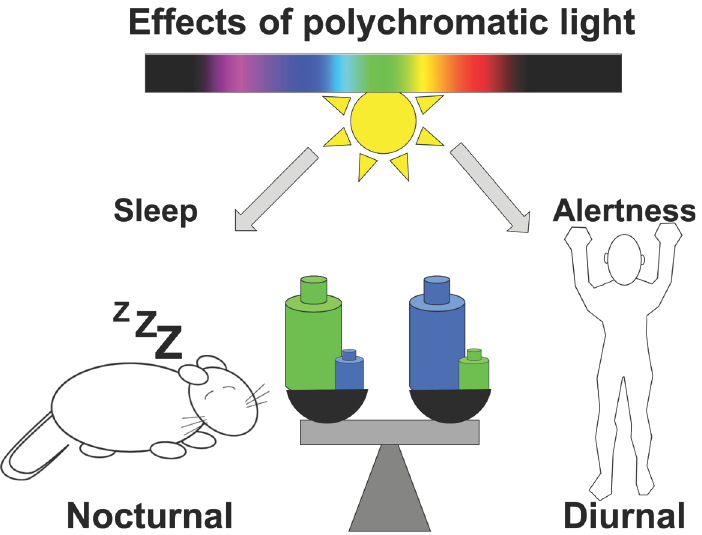
Fig 2. Light effects in diurnal and nocturnal species: A complex role of the spectral composition. Light is known to promote sleep in nocturnal species and alertness in day-active animals. Our hypothesis is that the opposite responses to natural polychromatic light may result from higher sensitivity of nocturnal species to green light, and diurnals to blue wavelengths, resulting in hypnogenic and alerting effects, respectively. This can be modeled as different blue and green weights on a balance, explaining either an alerting (higher sensitivity to blue) or sleep-promoting effect (greater sensitivity to green) of white light in diurnal and nocturnal species,